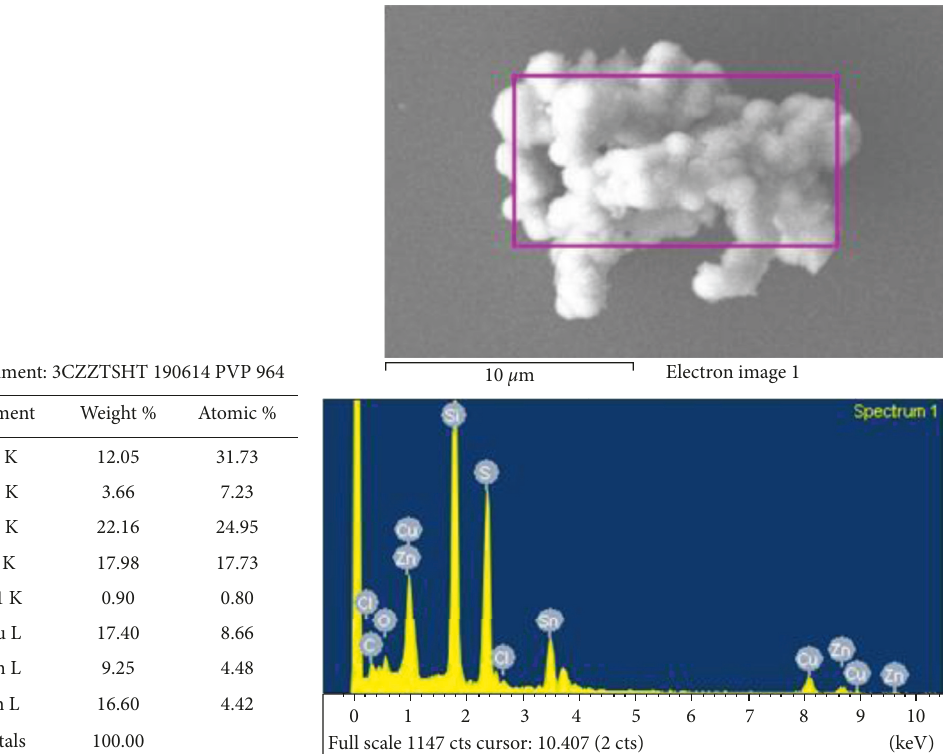
Figure 3: Composition of a representative sample, synthesized with 0.964g of PVP, obtained from EDS analysis.